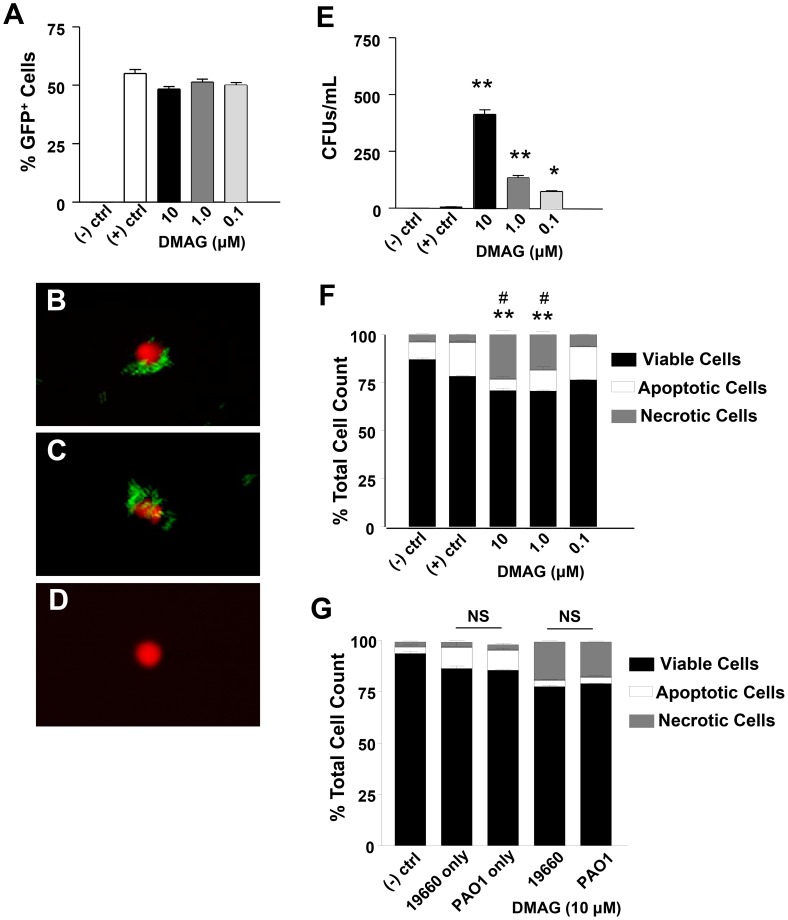
In vitro effects of HIF-1α inhibition on PMN function.Phaygocytosis (A), as measured by uptake of GFP+
P. aeruginosa 19660 by PMN, was not affected by DMAG-induced HIF-1α inhibition. Confocal laser scanning images documented intracellularly located GFP+ bacteria (green) with no DMAG treatment (positive control) (B) and after DMAG treatment (10 µM) (C). The negative control (no bacteria, no DMAG) (D) shows no GFP+ bacteria associated with the PMN, but stained positive for SYTOX Orange nuclear stain only. Intracellular killing by PMN (E) was analyzed by enumerating viable CFUs in the cell lysates. Significantly more viable bacteria were detected after DMAG treatment and affects were dose-dependent. Apoptotic and necrotic cells were measured (F) after HIF-1α inhibition and indicated that DMAG treatment significantly decreased apoptosis/increased cell necrosis in a dose-dependent response compared to positive controls (bacteria only, no DMAG). Apoptotic and necrotic cells were measured (G) after HIF-1α inhibition (10 µM) using both 19660 (a cytotoxic strain) and PAO1 (an invasive strain) and revealed no significant differences between cell viability, apoptosis and necrosis between the two bacterial strains. Data represent three independent experiments. *P<0.05, ** P<0.01 for apoptotic cell counts – (+) control versus DMAG treated; # P<0.01 for necrotic cell counts – (+) control versus DMAG treated. B, C, D magnification = 1,000×. NS = Not Significant.